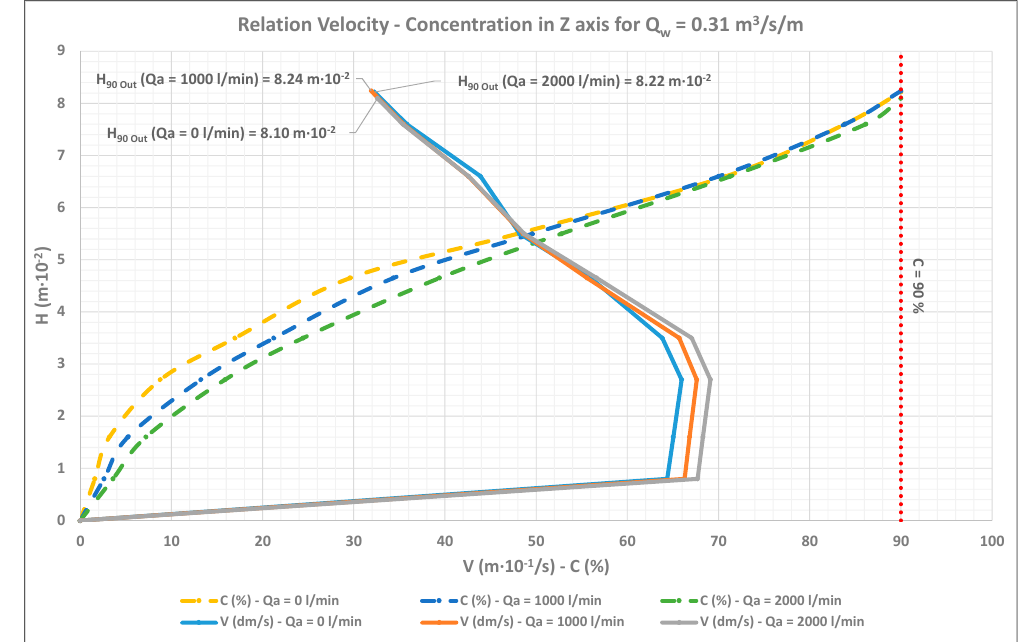
Figure 7. Relation between depth (H) and velocity (V)—Concentration (C) profiles in scenario 1 (Q w = 0.31 m 3 /s/m).